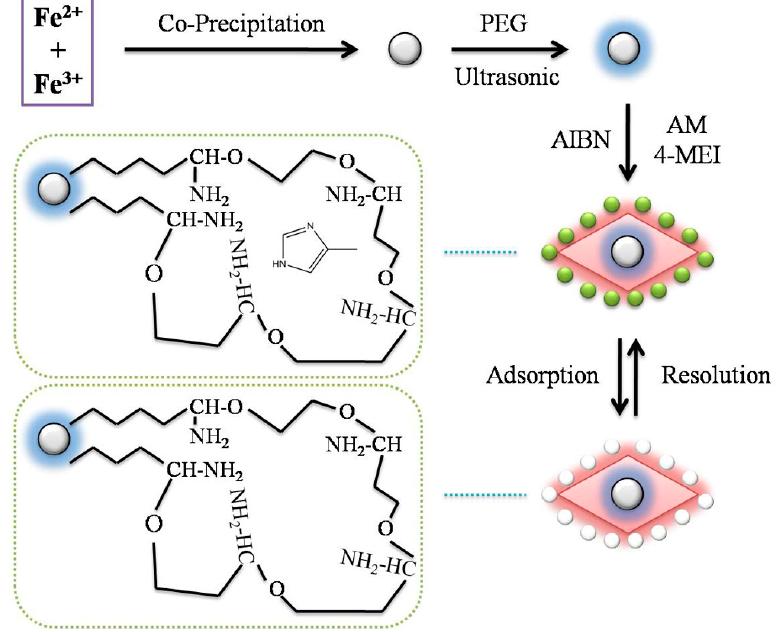
Figure 1. Schematic illustration for the synthetic route of 4-MEI-MMIPs.